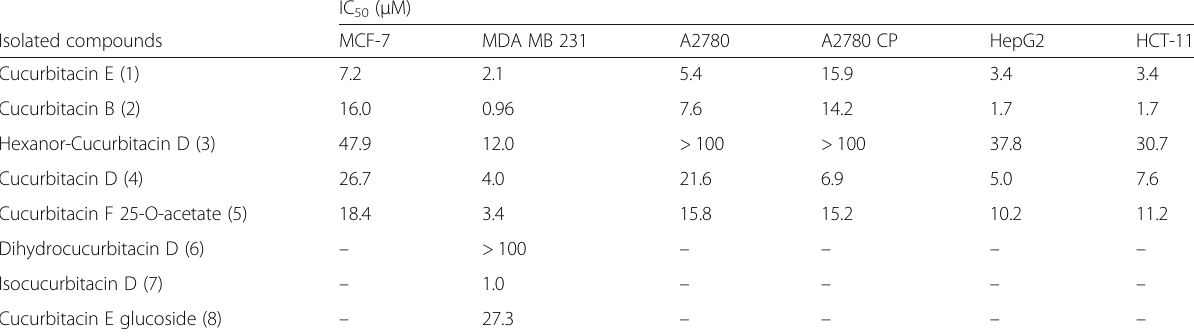
Table 5 Cytotoxic effects of tested